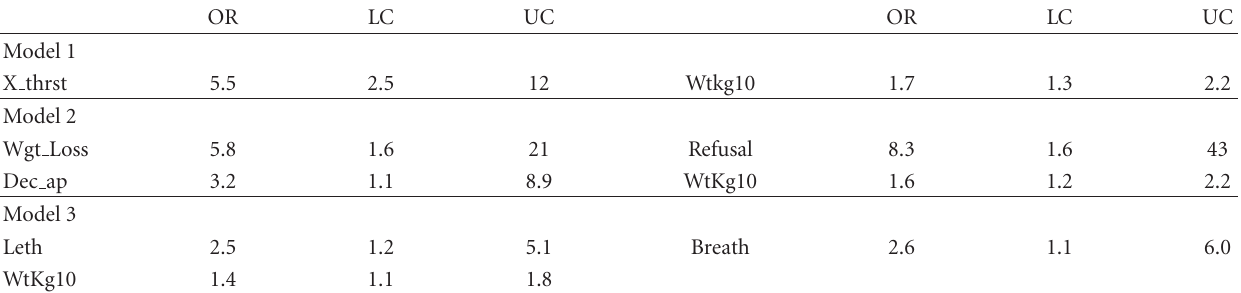
Table 4: Biologic systems models regarding urinary symptoms (Model 1), weight loss (Model 2) and miscellaneous (Model 3)—adjusted for dog weight 1,2,3